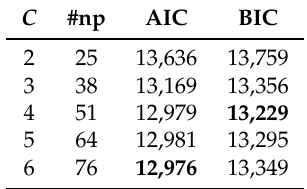
Table 2. Data illustration dichotomous data: model comparison for exploratory latent class models (LCMs). C #np AIC BIC 25